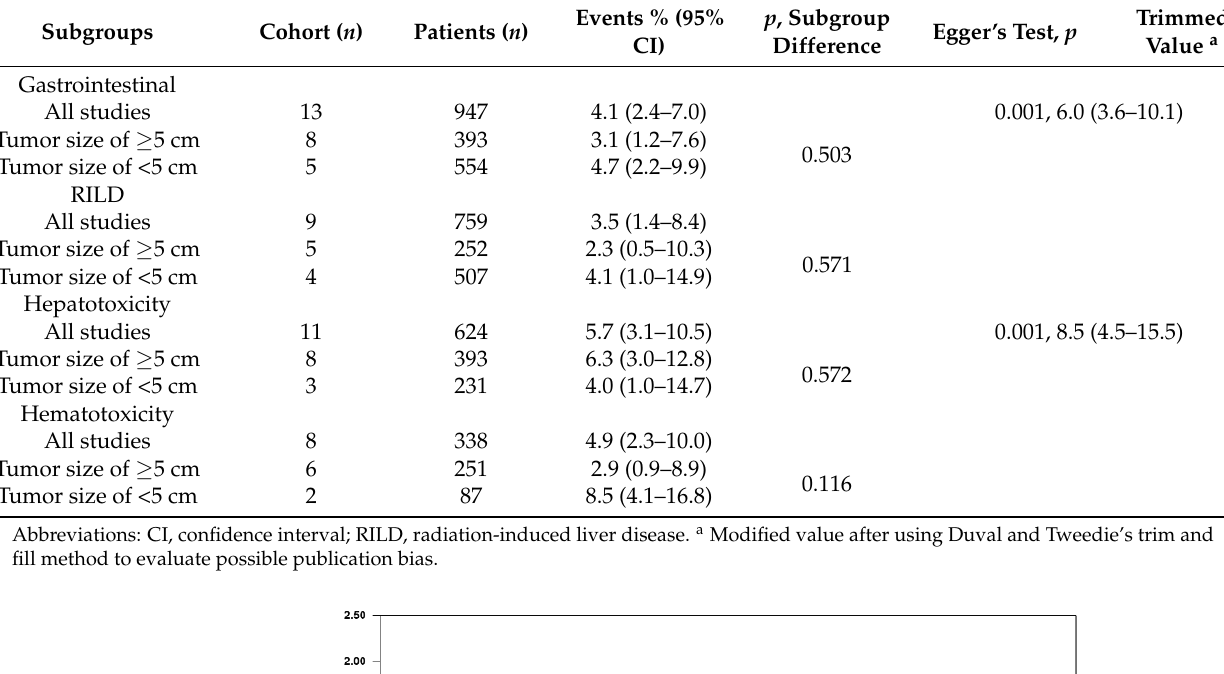
Table 4. Pooled analysis of grade ≥ 3 complications.